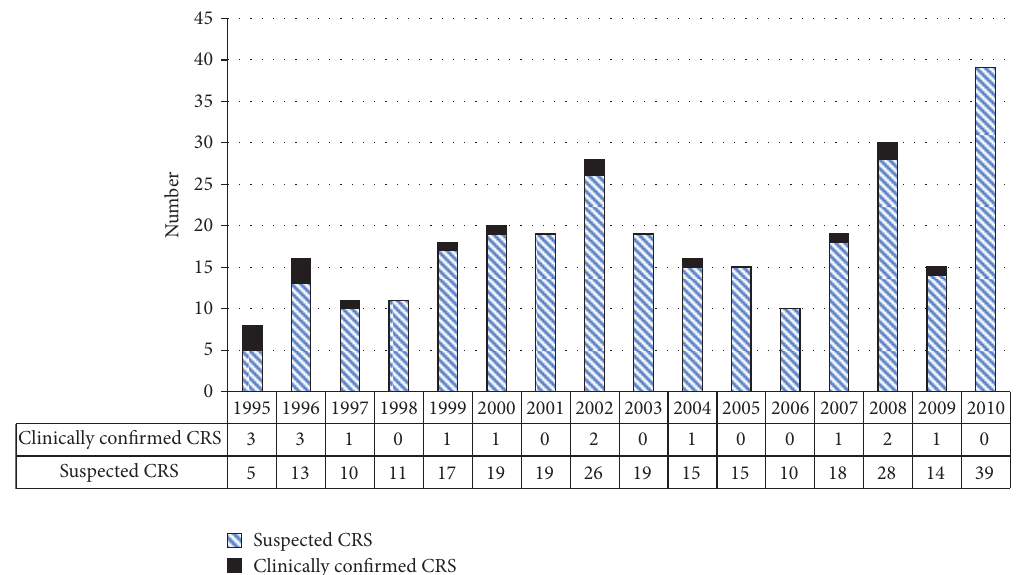
Figure 2: Classification of congenital rubella syndrome (CRS) by year, Fiji,